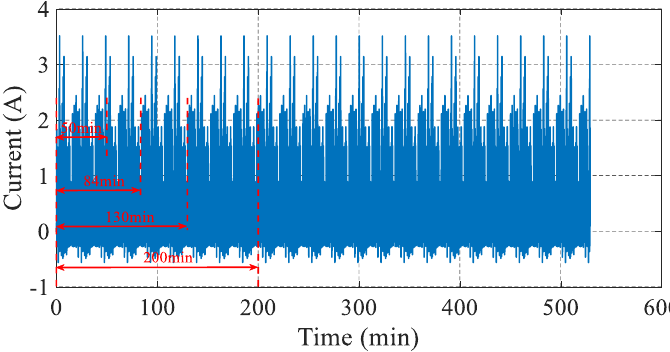
Figure 6. The urban dynamometer driving schedule (UDDS) current. Table 3. The estimation results and errors of the battery capacity corresponding to various data lengths.